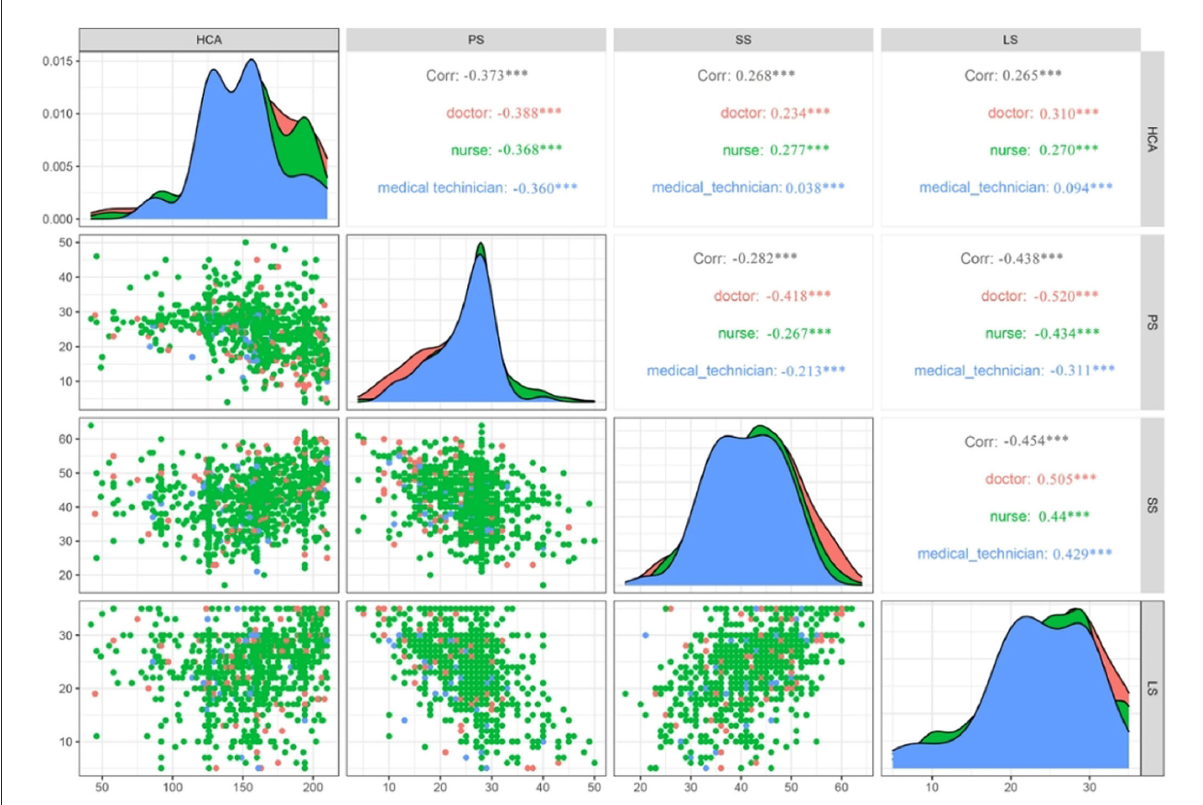
FIGURE1 The Spearman correlations of humanistic care ability with other major variables ( n =